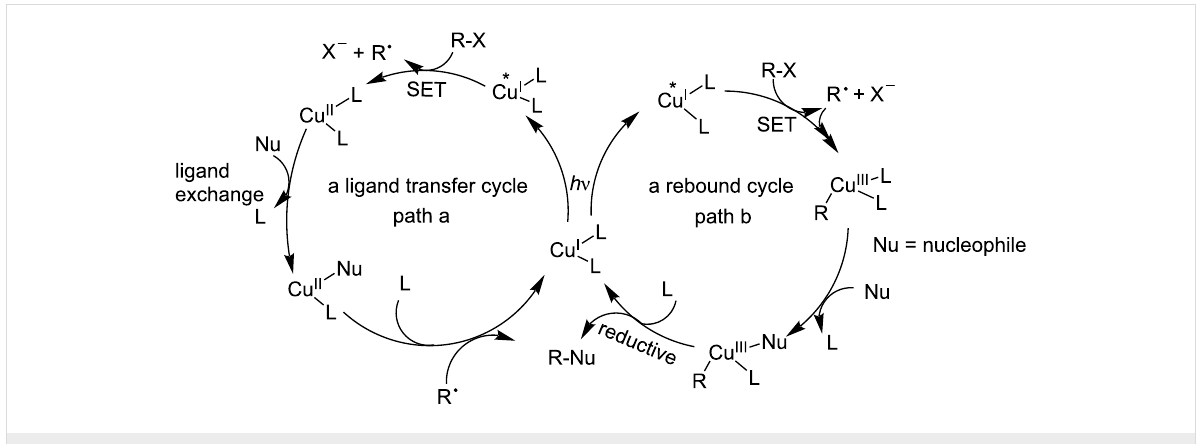
Scheme 4: Mechanism of Cu I -based